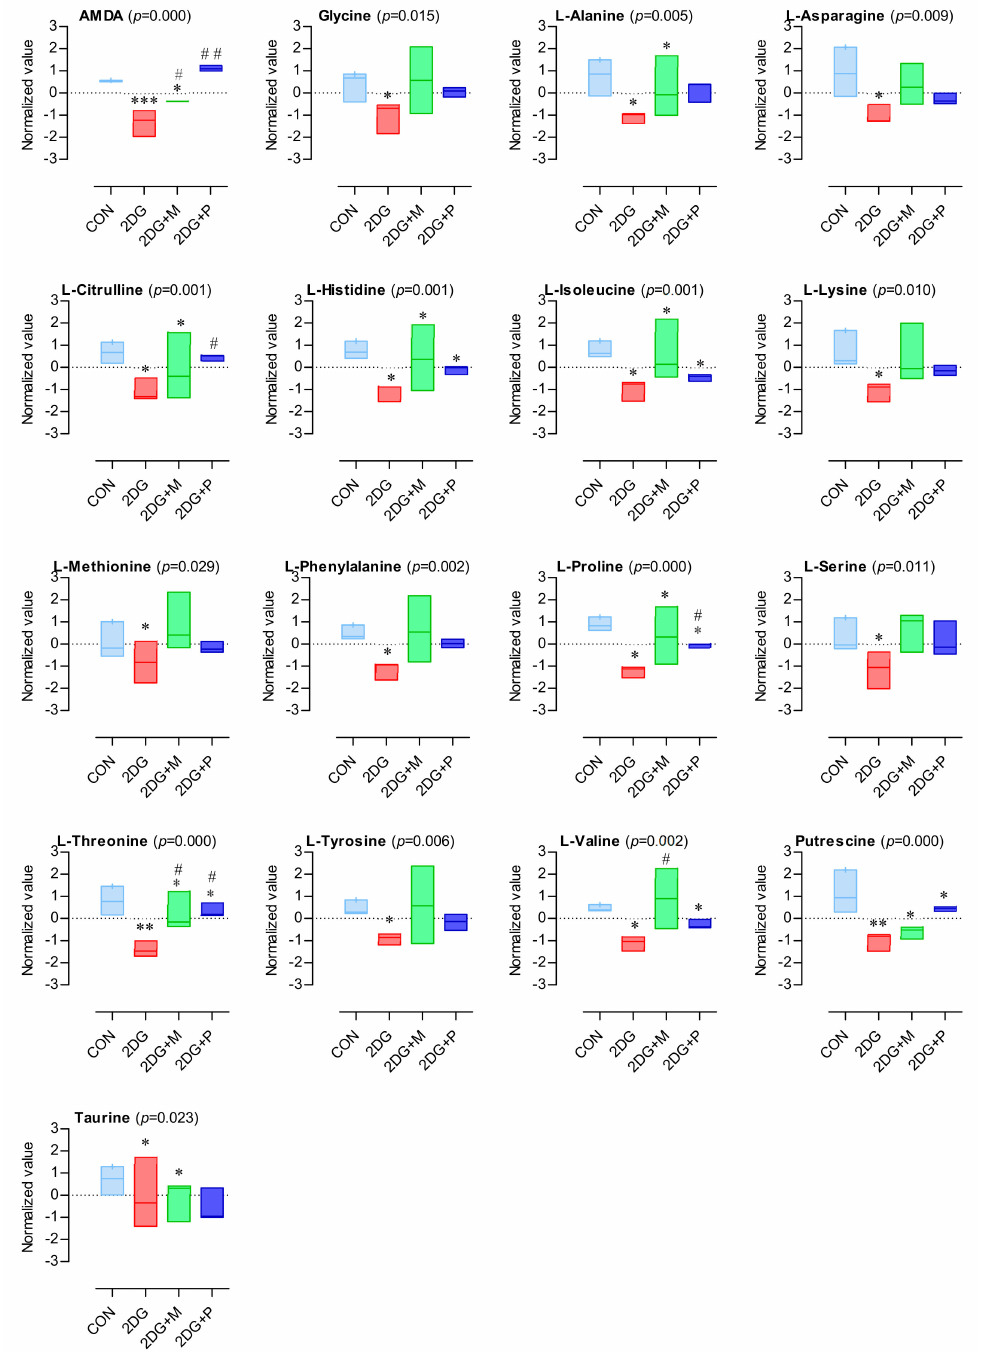
Figure 5. Box plot of altered amino acid and biogenic amine levels. Normalized values of all the experimental groups were determined by the MetaboAnalyst, a web-based platform (normalization by median, auto-scaling). Significant di ff erences among the groups were assessed using one-way ANOVA ( p -value < 0.05, Tukey’s HSD). The box plots were generated using GraphPad Prism; One-way ANOVA with Tukey’s multiple comparison test; ***: p < 0.001, **: p < 0.01, *: p < 0.05 (vs CON); ##: p < 0.01, #: p < 0.05 (vs